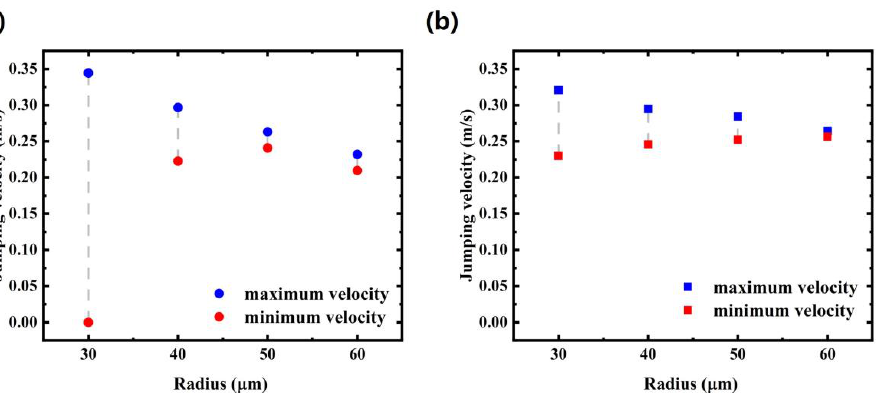
Figure 9. ( a ) Deviation of droplet jumping velocity on the original surface. ( b ) Deviation of droplet jumping velocity on the refined surface. The range of results is achieved by adjusting the initial position of the droplet.